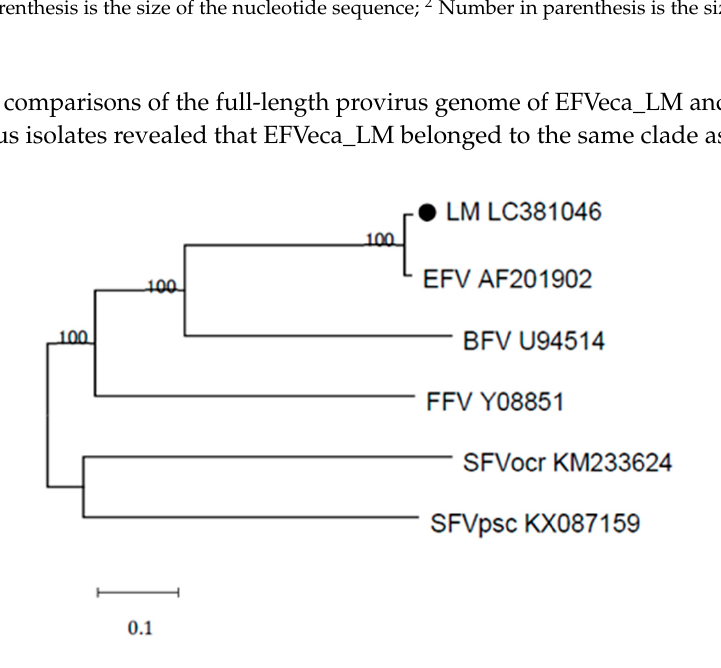
Figure 3. Phylogenetic analysis of the Japanese isolate EFVeca_LM (LM LC301046) and other foamy virus strains. The phylogenetic tree was generated using complete nucleotide genome sequences. EFVeca_LM is indicated by a closed circle. Bootstrap values less than 50% are not shown on the corresponding nodes. BFV: bovine foamy virus, FFV: feline foamy virus, SFVocr: simian foamy virus Otolemur crassicaudatus, SFVpsc: simian foamy virus Pan troglodytes schweinfurthii.